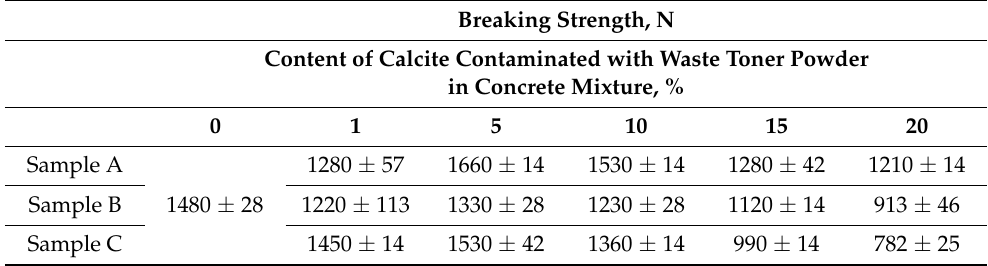
Table 6. Breaking strength of concrete with the addition of calcite contaminated with waste toner powder. Breaking Strength,